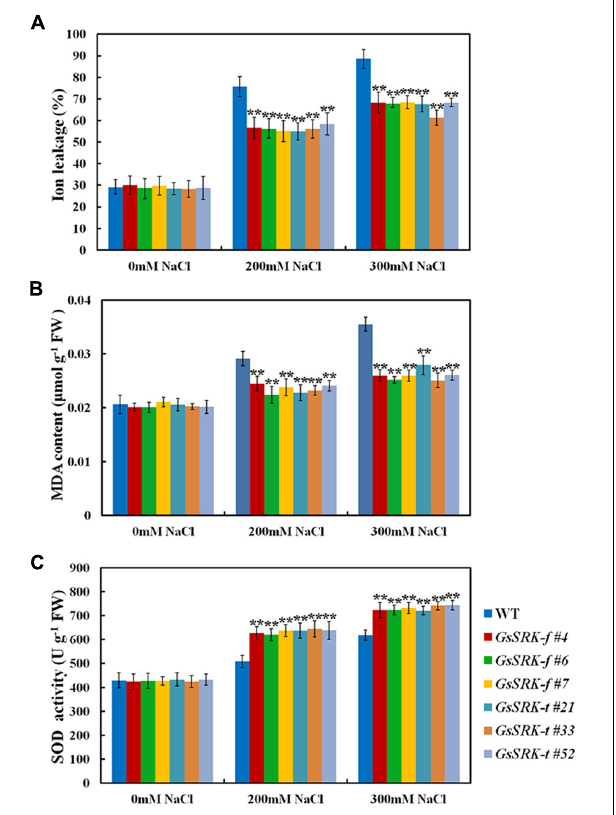
FIGURE 6 | GsSRK is involved in regulating ROS scavenging under salt stress. (A) The relative ion leakage of the WT and transgenic alfalfa under control conditions and salt stress. (B) The MDA content of the WT and transgenic alfalfa under control conditions and salt stress. (C) The SOD activity of the WT and transgenic alfalfa under control conditions and salt stress. Data are means ± SE ( n ≥ 6). ∗∗ P < 0.01 by Student’s t